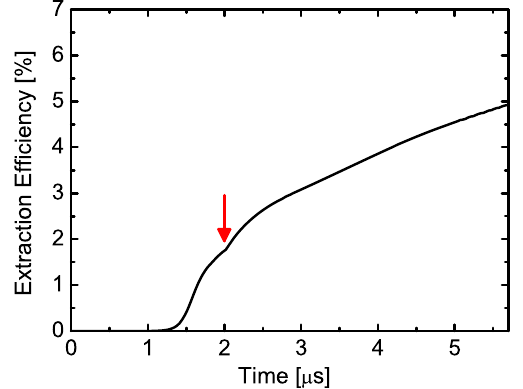
13. The evolution of the extraction efficiency directly calculated from the numerical result shown in Fig. 10. The arrow indicates the timing of the cavity detuning condition altering from 9 . 4 μ m to 0 μ